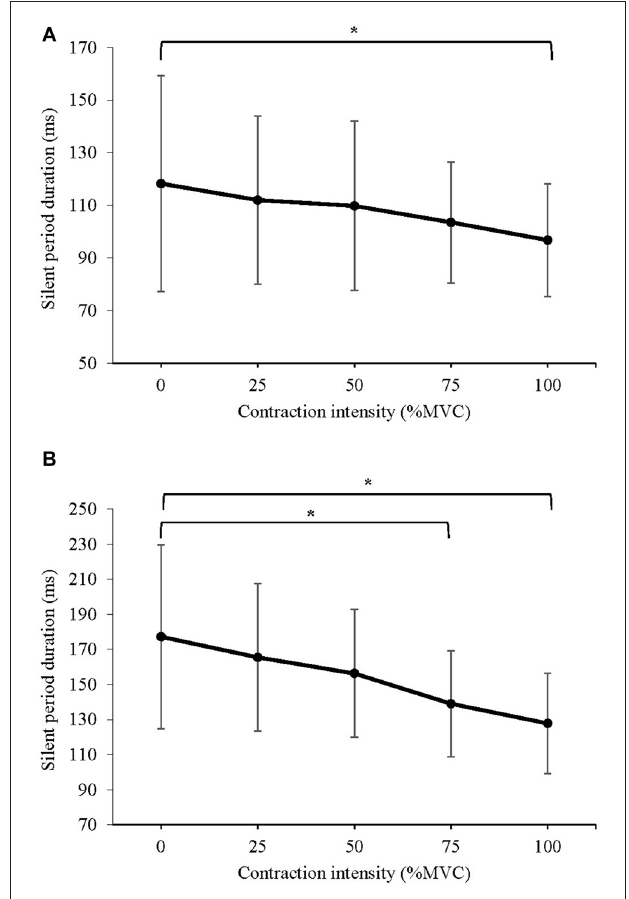
FIGURE 6 | Mean ± SD silent period duration of MEPs evoked at (A) 120% AMT, and (B) 150% of AMT. For MEPs collected at 120% AMT, there was an 18% reduction in the silent period during 100% MVC. For MEPs collected at 150% AMT, contractions of 75% and 100% MVC produced a 22% and 29% reduction in the silent period,